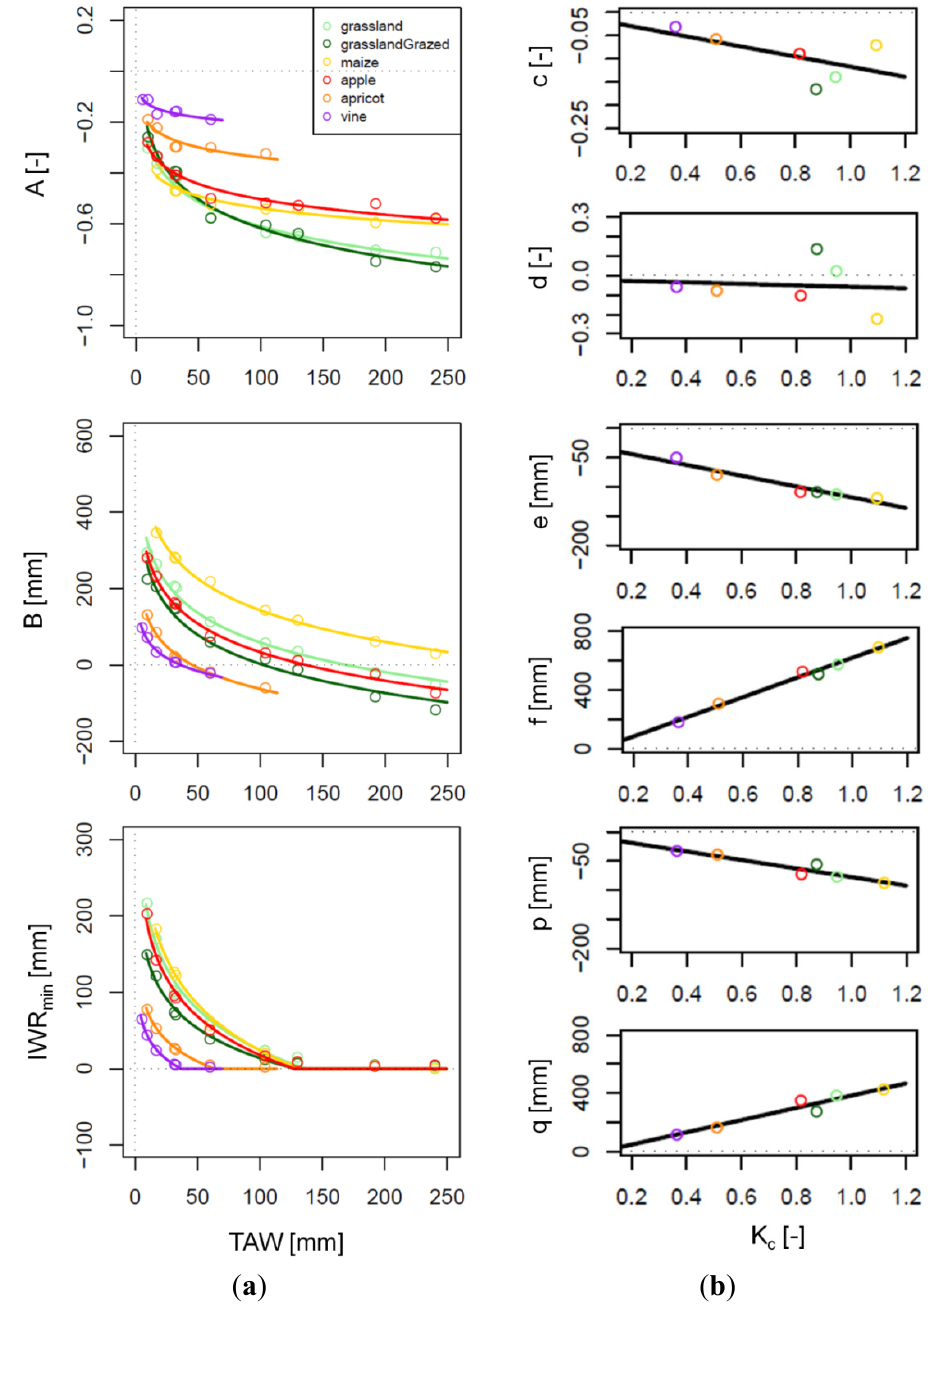
Figure 3. Modulation of the generic relationship between IWR water holding capacity ( a ) TAW ; and crop type ( b ) K Equation (12) in the left panel and Equation (13) in the right